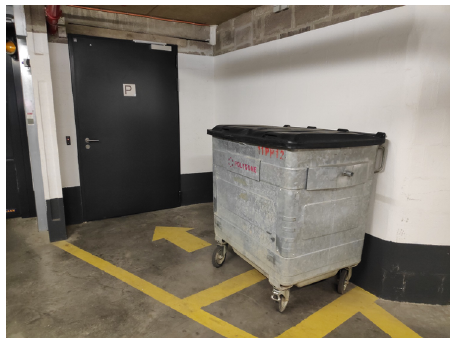
Figure 11. Indoor technical room where Sigfox connectivity was